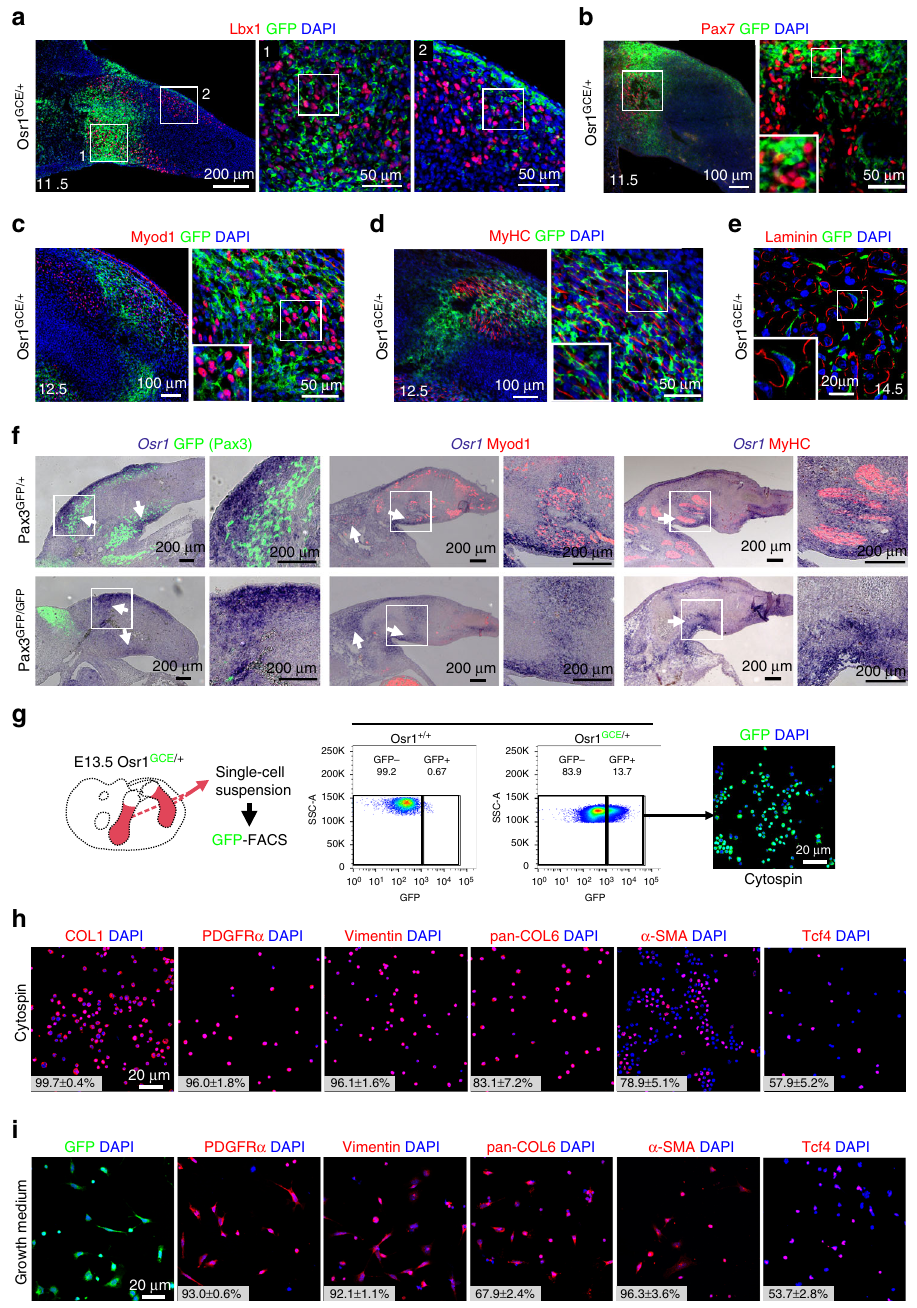
Fig. 1 Osr1 is expressed in limb mesenchymal cells associated with myogenic cells and labels MCT cells. a – e Osr1 expression was assessed by immunolabelling for GFP on Osr1 GCE/ + embryos at the indicated stages. Osr1 + cells are found interstitial to Lbx1 + , Pax7 + and MyoD1 + myogenic progenitors and interstitial to developing myo fi bres labelled either for Myosin heavy chain (MyHC) or Laminin. Note that in some developing muscles Osr1 + cells are abundant, while being scarce in others. Boxed regions (numbered in a ) are shown in the panels to the right of overview images and are magni fi cations of the area. f Osr1 expression was analysed by in situ hybridization to sections of muscleless limbs of E11.5 (left), 12.5 (middle) and 13.5 (right) Pax3 mutant embryos. The overall expression pattern of Osr1 is similar in limbs of Pax3 GFP/ + and Pax3 GFP/GFP embryos. Arrows highlight strong Osr1 expression observed in control and muscleless limbs. Boxed regions are shown in the panels to the right of overview images and are magni fi cations of the area. g Schematic depiction of limb Osr1 + cell isolation procedure and examples of FACS plots. h Expression of fi broblastic markers in freshly FACS-isolated Osr1 + cells subjected to cytospin. ( n = 3). i Osr1 + cells cultured in growth medium maintained the expression of fi broblastic markers ( n = 3). Insets in h , i are percentage of COL1 + , PDGFR α + , Vimentin + , Pan-COL6 + , α SMA + and Tcf4 + cells among the Osr1 + cell population. Values represent mean ± s.e.m. N-numbers indicate biological replicates, i.e. samples from different